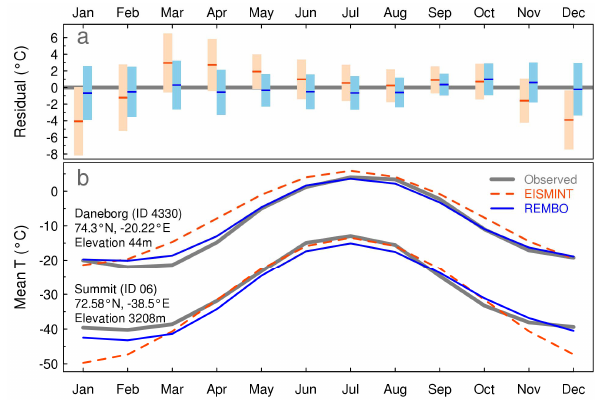
Figure 2. (a) Average and standard deviation of monthly residuals of REMBO (blue) and EISMINT (red) temperatures compared to station data at 52 locations. (b) Monthly temperatures from REMBO (solid blue line) and the EISMINT temperature parameterization (dashed red line), orographically-corrected and compared with DMI station data (thick grey line) for one high- and one low-elevation station on Greenland.